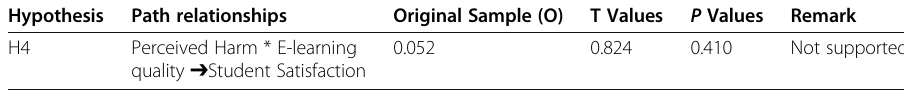
Table 6 Moderation effect Hypothesis